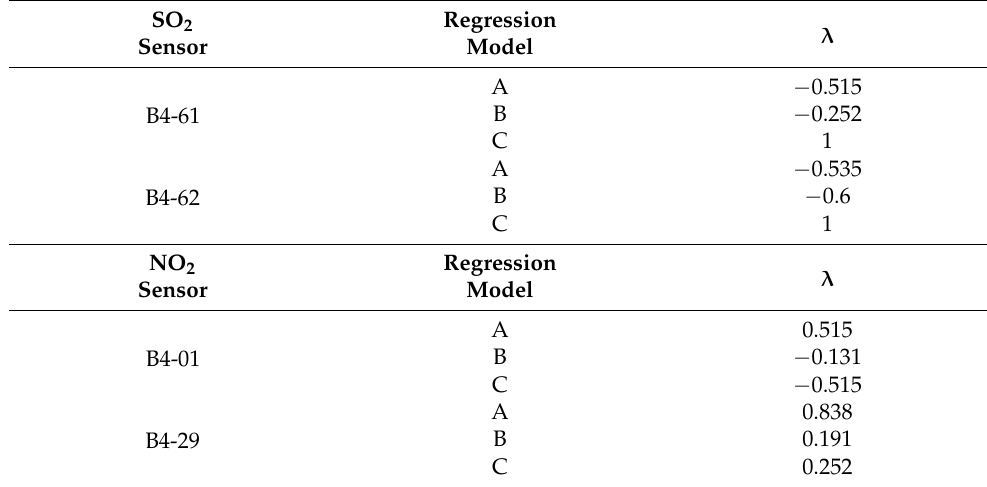
Table A1. Lambda values used in data normalization by Box–Cox transformation. SO